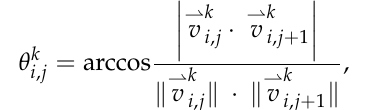
(cid:3038) and 𝑣⃑ (cid:3038) can be calculated as (cid:3036),(cid:3037) (cid:3036),(cid:3037)(cid:2878)(cid:2869)